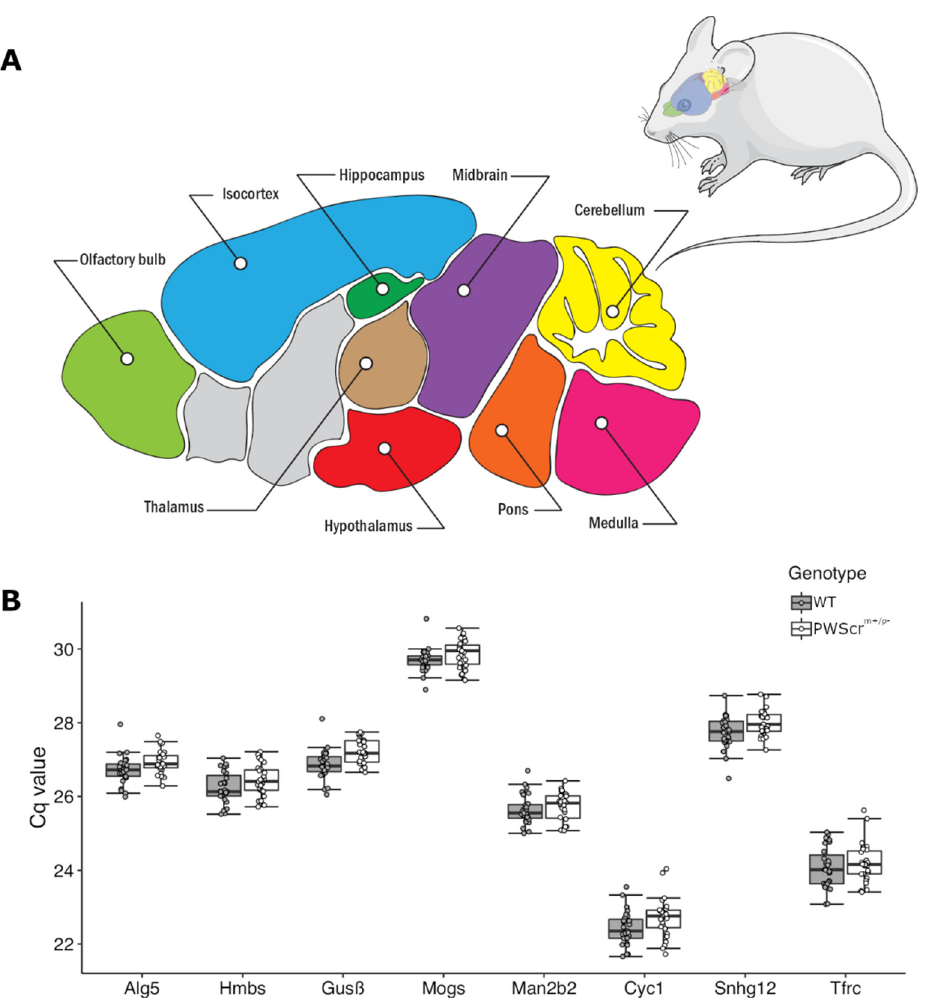
Figure 1. Mouse brain regions and expression of selected reference gene candidates. ( A ) Schematic representation of a sagittal section of an adult mouse brain with nine analyzed regions (colored and labelled). Areas that were not analyzed are shown in gray. ( B ) The resulting Cq values of the selected eight reference gene candidates in all nine brain regions analyzed (mean ± SD). Wild-type bars are depicted in dark gray, PWScr m+/p— in white.